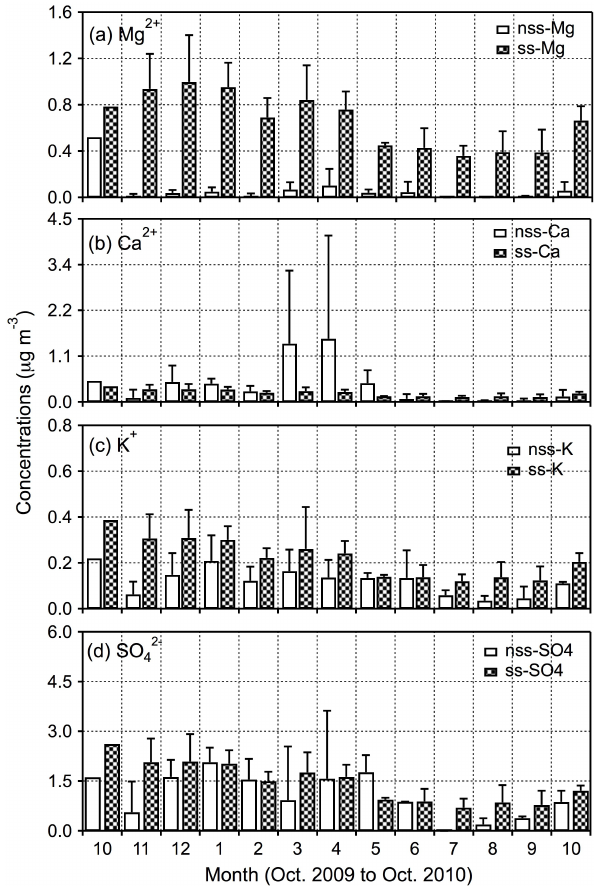
We found that NH + plays a major role in the neutralization of 4 acidic species. The order of NF is NH + >Ca 2 + >K + >Mg 2 + . 4 4 The NF of NH + and Ca 2 + were found highest in winter 4 followed by spring, suggesting that all the acidic species were neutralized with CaCO 3 , MgCO 3 and NH + . Ca 2 + 4